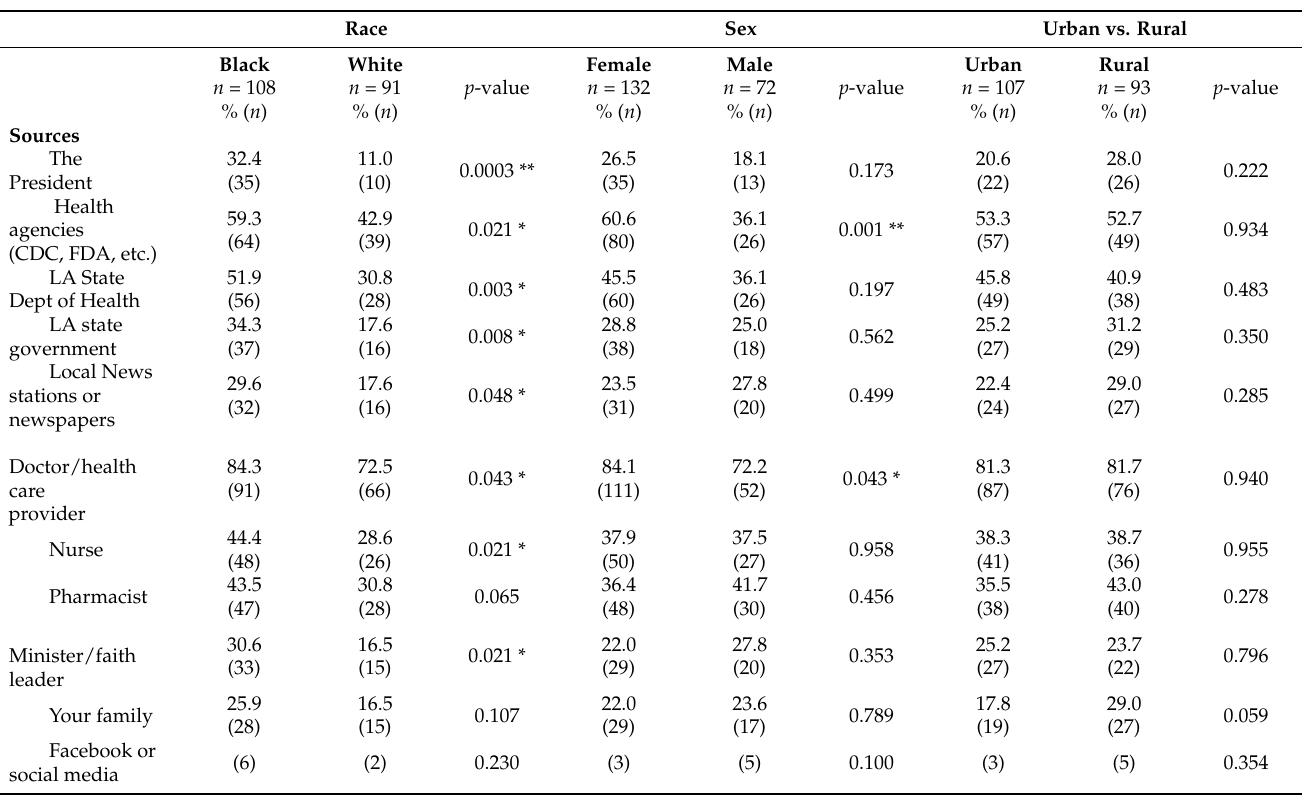
Table 3. Trusted Sources for COVID-19